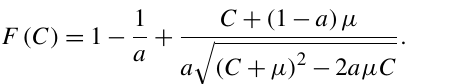
Table 1. The boundary conditions of the functions for relating the wetting ratio (2) the VIC type of model, and (3) the modified SCS-CN method based on the proposed new distribution for the VIC type of model. Surface runoff model Parameters Lower boundary condition Upper boundary condition SCS-CN, parameterization of initial S p ,ε W wetting (cid:56) sc → 0 (cid:56) sc → ∞ Generalized Pareto distribution for C m ,β W storage capacity (VIC type of model) (cid:56) sc ≤ b (cid:56) sc → ∞ Modified SCS-CN method based on S b ,a W the proposed distribution for storage (cid:56) sc → 0 capacity as (cid:56) sc →